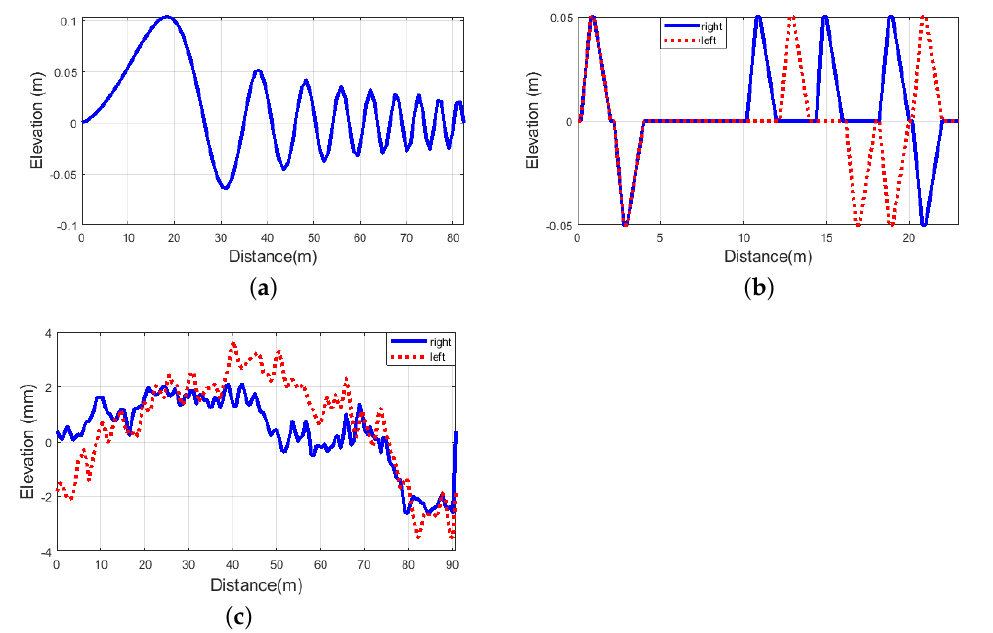
Figure 9. ( a ) Sine- sweep road. ( b ) Several bumps. ( c ) Road roughness. The operation of the proposed adaptive semi-active suspension controller in case of several bumps on the road is depicted in Figures 10–12. It is well demonstrated that with the comfort-oriented setting of ρ = 1, vertical acceleration is decreased compared to the stability-oriented controller setting of ρ = 0, as shown in Figure 10. Thus, through the smaller values of sprung mass vertical acceleration, passenger comfort can be enhanced with the adaptive